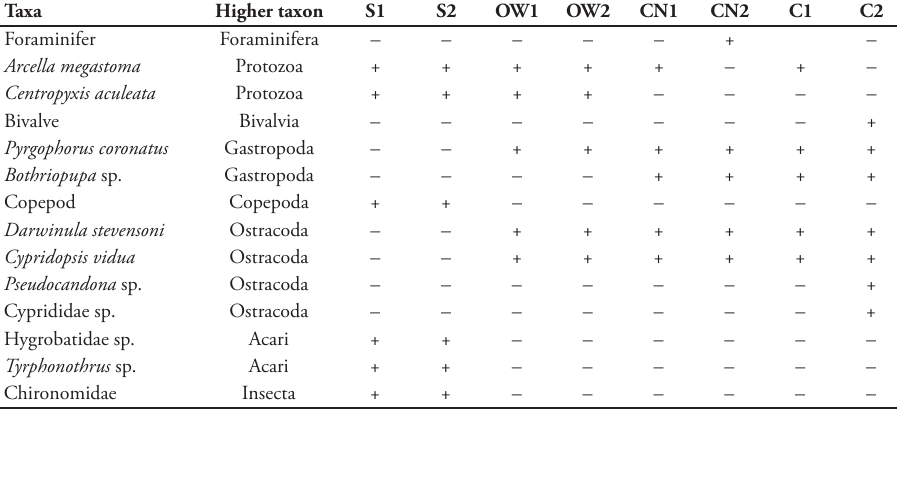
Table 2. Occurrence of the benthic taxa extracted from eight sediment samples of four zones of Cenote X-Batún. S1 = water surface 1, S2 = water surface 2, OW1 = open water 1, OW2 = open water